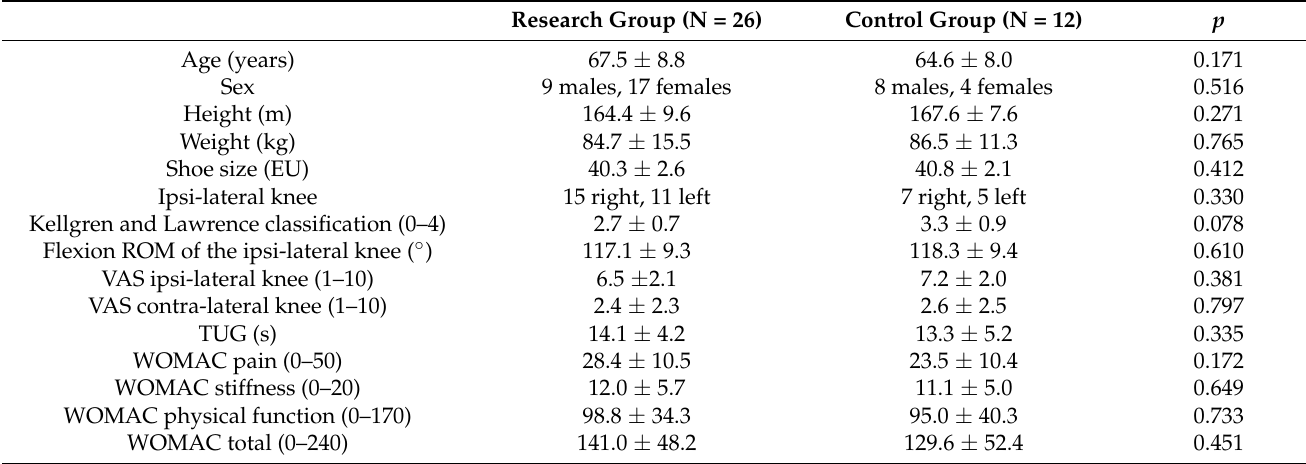
Table 1. Personal characteristics of the subjects at baseline. ROM = Range of Motion; VAS = Visual Analogue Scale; TUG = timed up and go; WOMAC = Western Ontario and McMaster Universities Arthritis